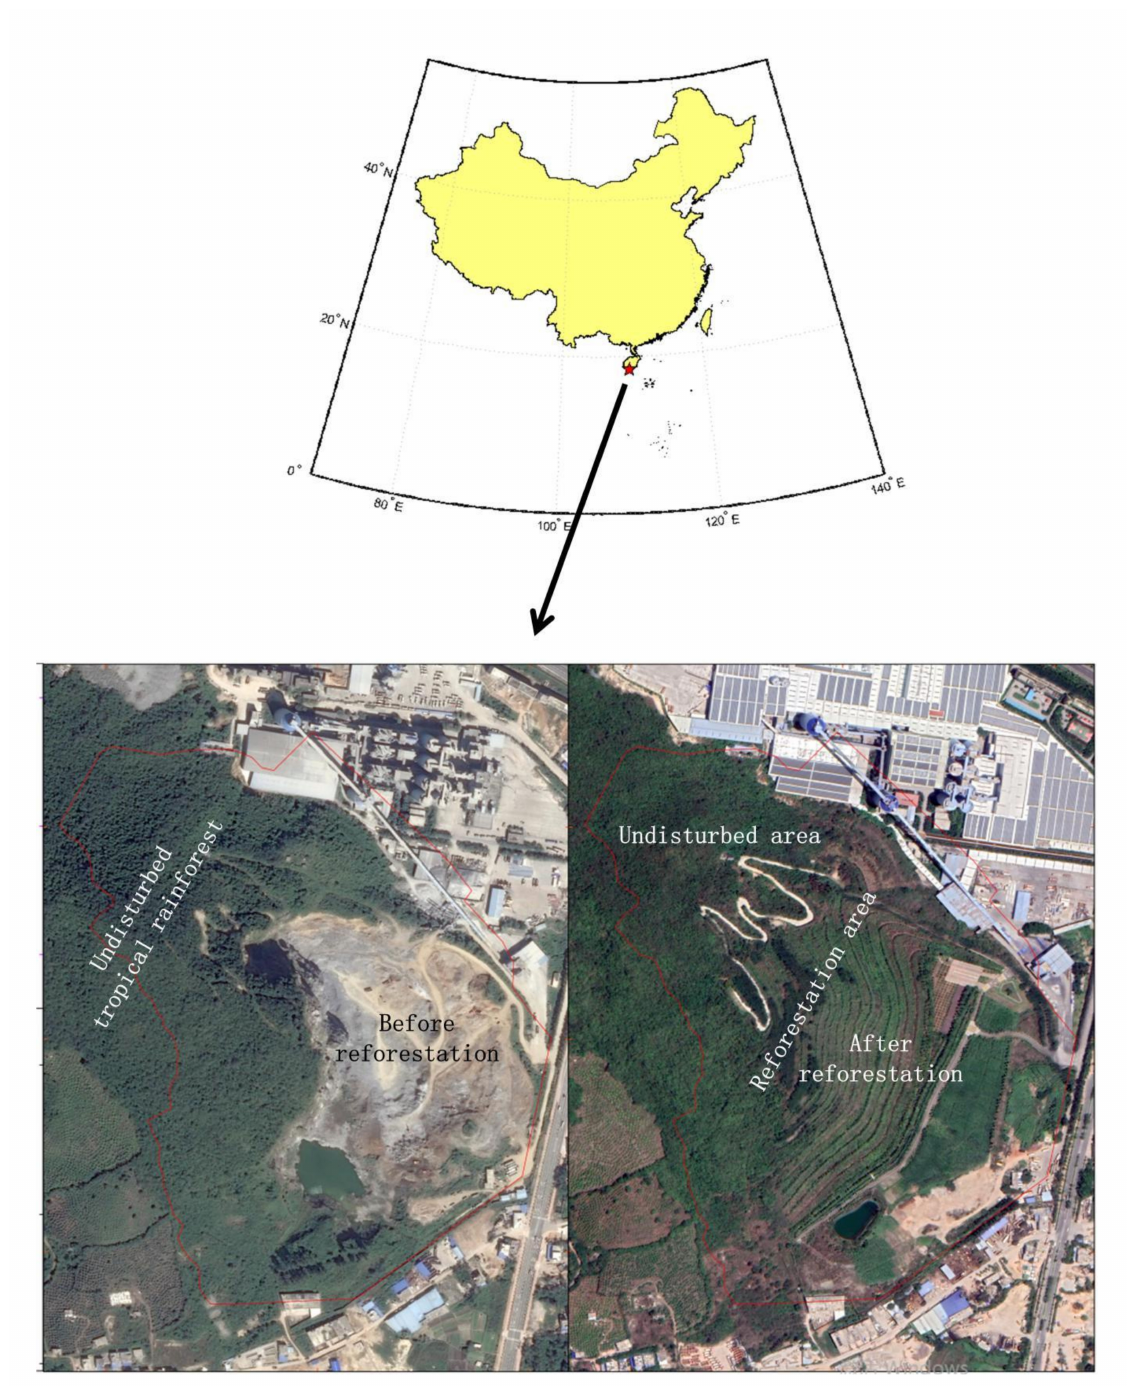
Figure 2. The map of the study site (Baopoling mountain) and the landscape of the 0.2 km 2 highly degraded area before and after reforestation: leaf samples for the eight nonnative and the native tree species,